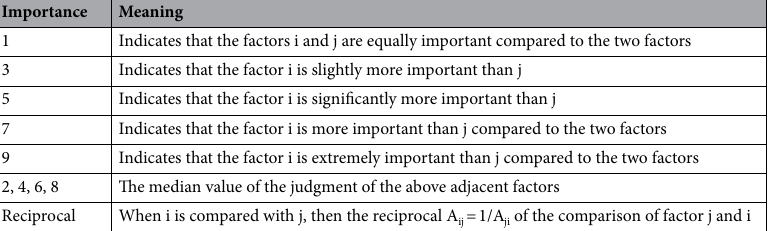
Table 1. Rules for evaluating the importance of indicators in the analytic hierarchy process (AHP)